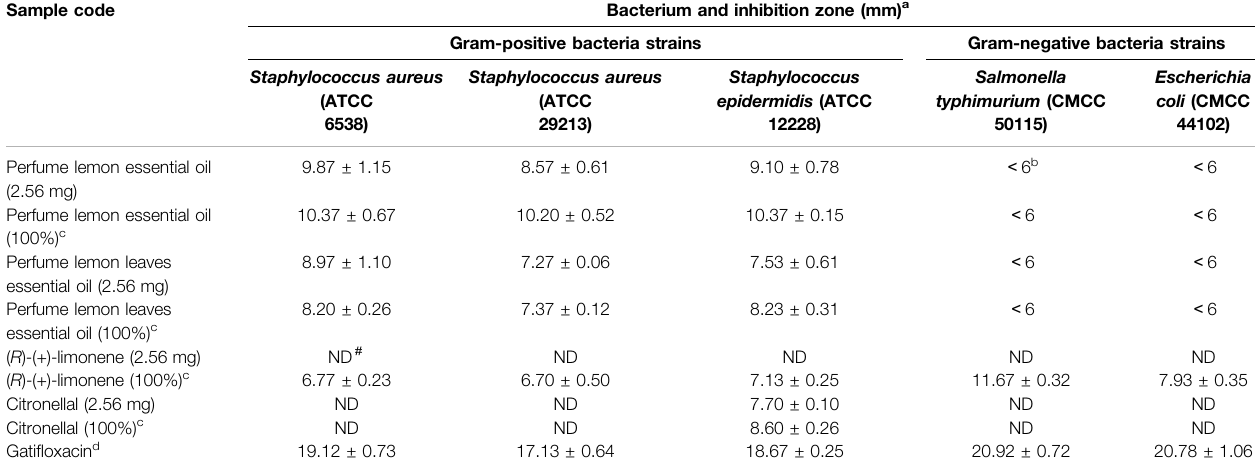
TABLE 2 | Biological evaluation of the two essential oils expressed in the inhibition zone